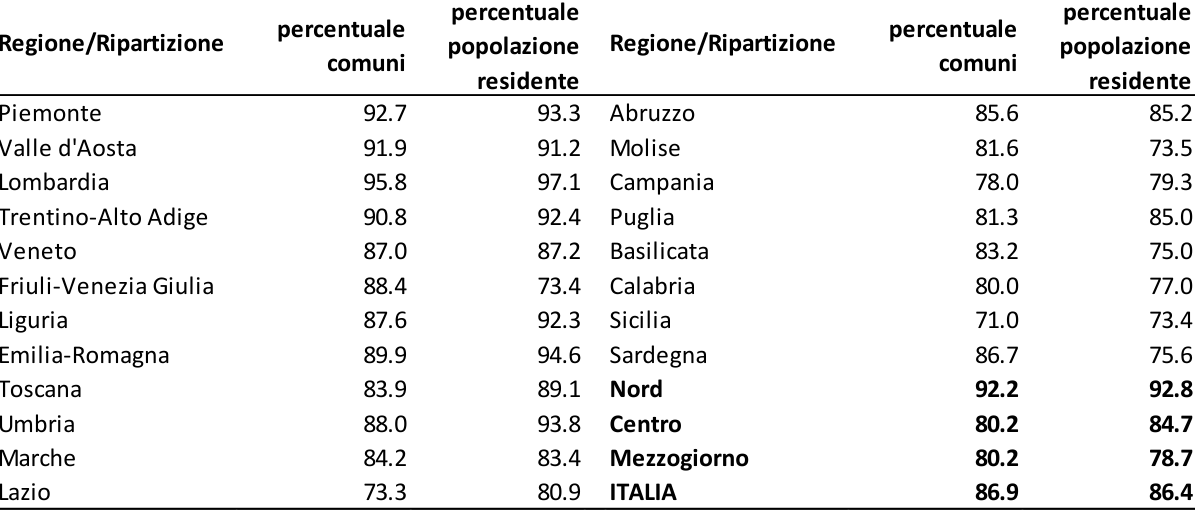
Tabella A2. Copertura regionale e ripartizionale per comune e popolazione residente dei 6.866 comuni diffusi